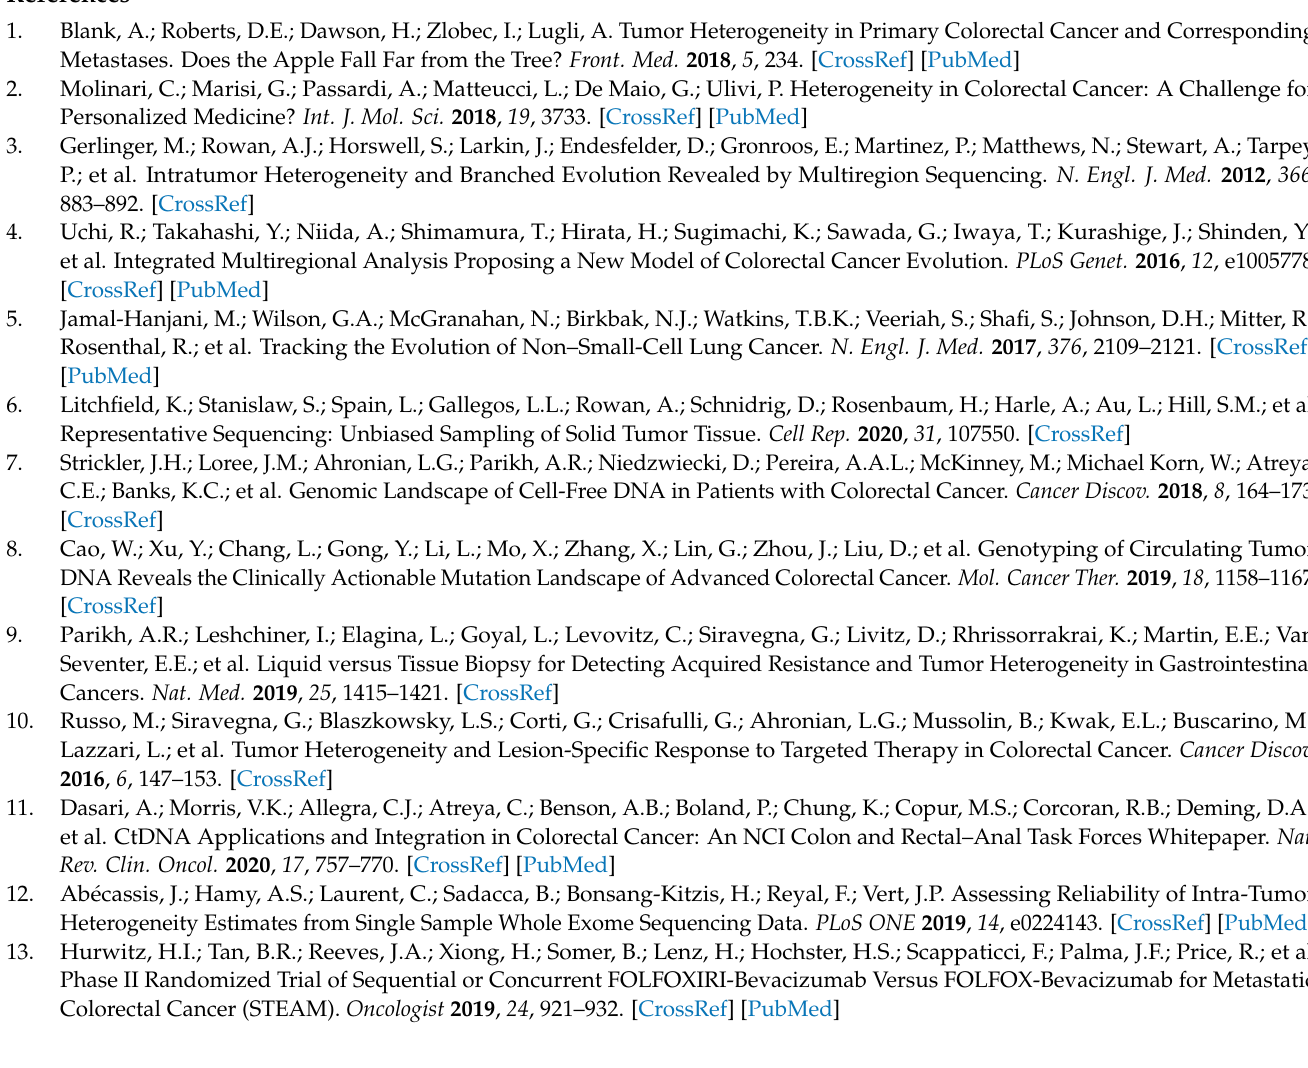
Figure A5. Examples showing variant allele frequencies and MATH. Changes in MATH and AF of individual mutations from pre-induction to post-induction plasma in two cases.